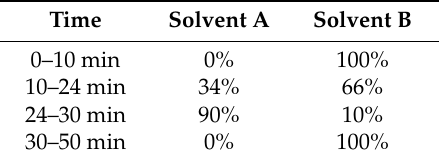
Table 2. Gradient program for the high-performance liquid chromatography (HPLC)